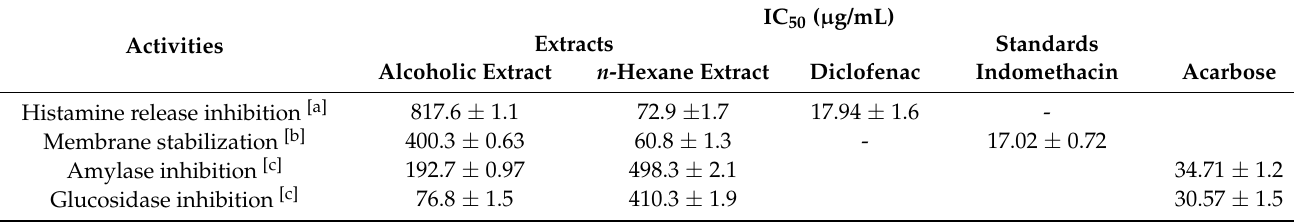
Table 1. Anti-inflammatory and antidiabetic activities of Pulicaria jaubertii alcoholic and n -hexane extracts.